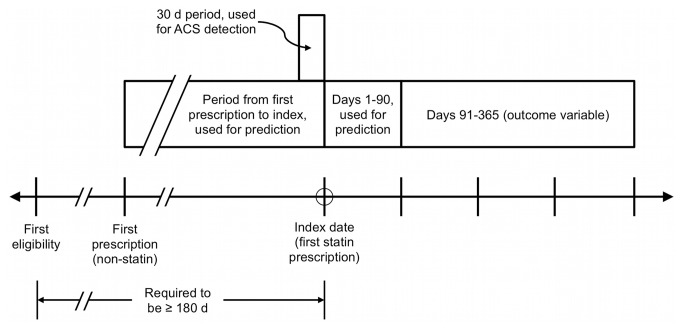
Timeline showing periods used to calculate adherence measures and baseline variables.Outcome variable is proportion of days covered (PDC) by statin for days 91-365, respectively. Three baseline variables are calculated from the first non-statin prescription to the index date. Presence of ACS (acute coronary syndrome) as a baseline variable was determined in the 30 days prior to statin initiation. Nine baseline variables including early PDC are calculated from statin prescriptions in days 1-90. Time from eligibility to initiation is required to be 180 days (in both models) in order to include those truly initiating statins, and not those merely continuing statins after switching insurance plans.